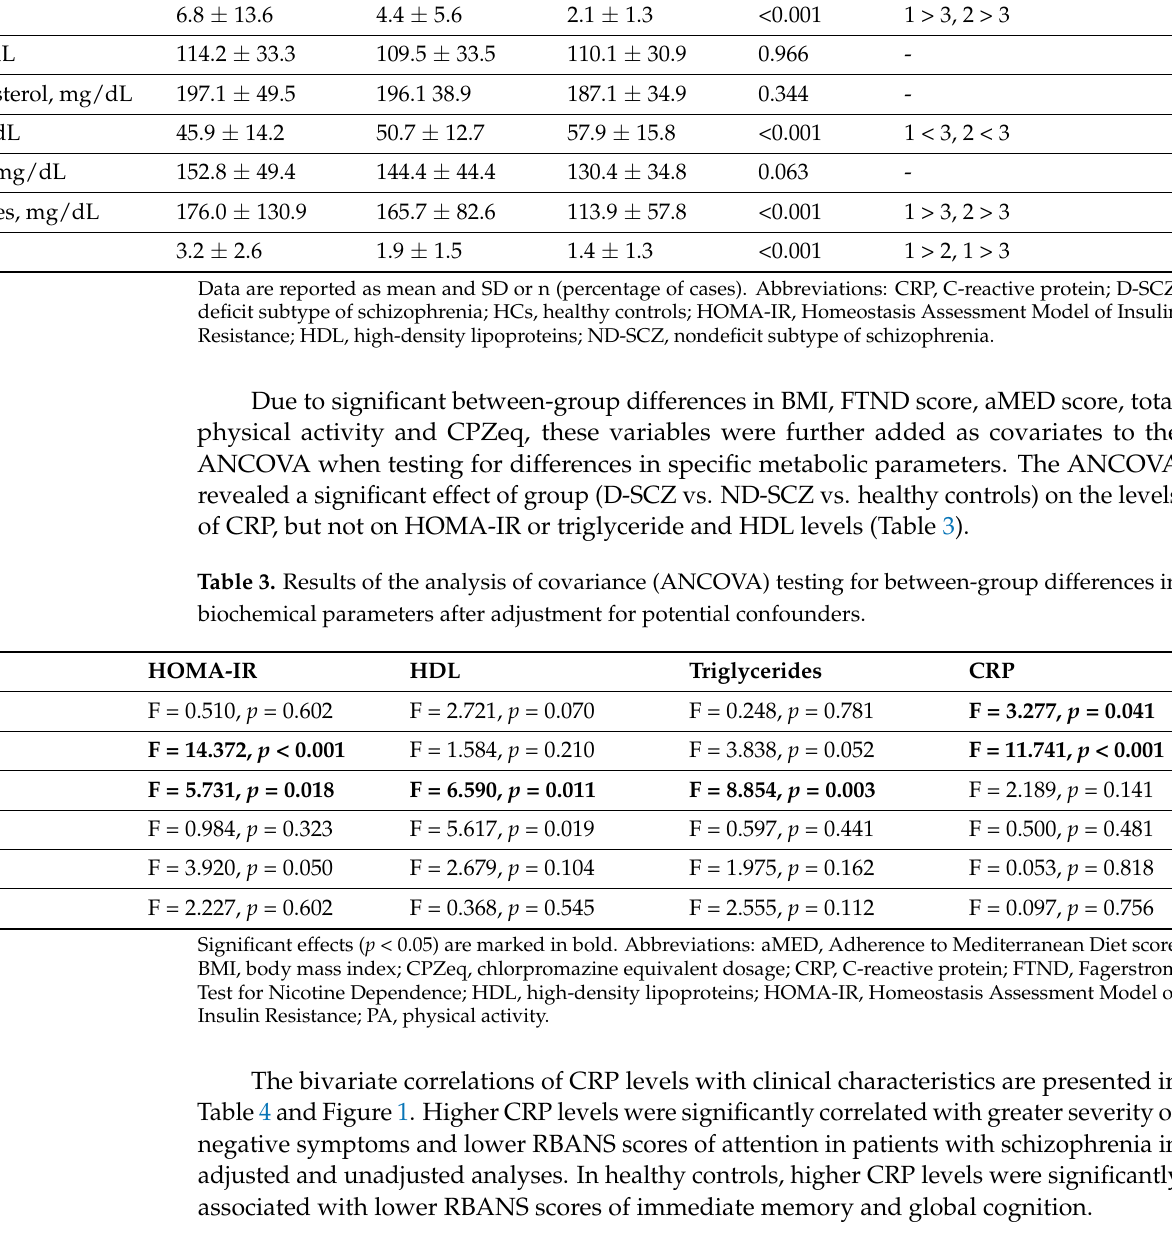
Table 4. Bivariate correlations of CRP levels with clinical manifestation and cognitive